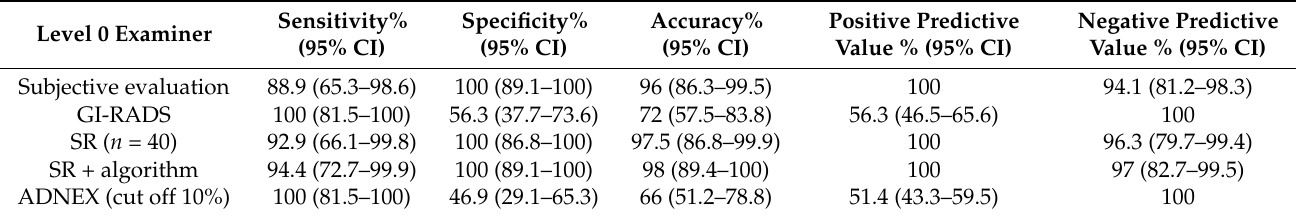
Table 4. Diagnostic performance of models based on student’s (level 0)